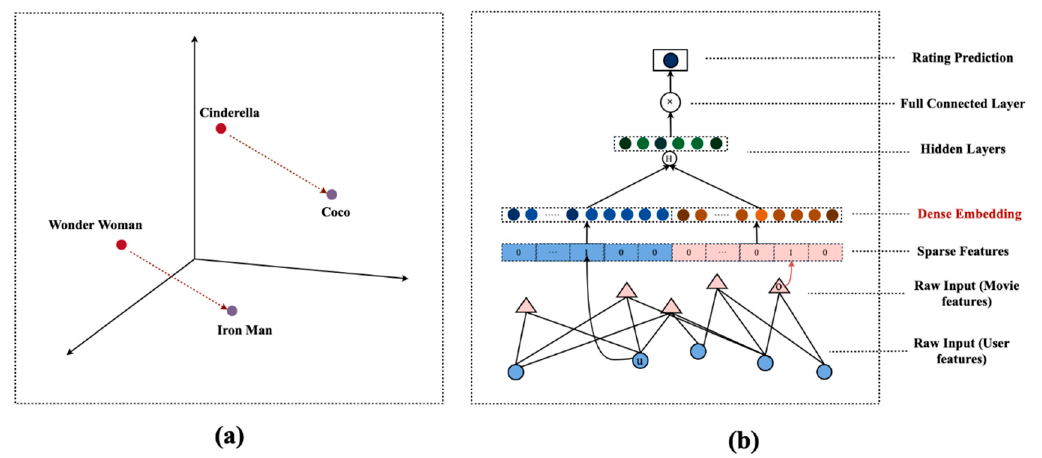
Figure 4. ( a ) The diagram of embedding space; ( b ) The overall network architecture of the embedding-training model.